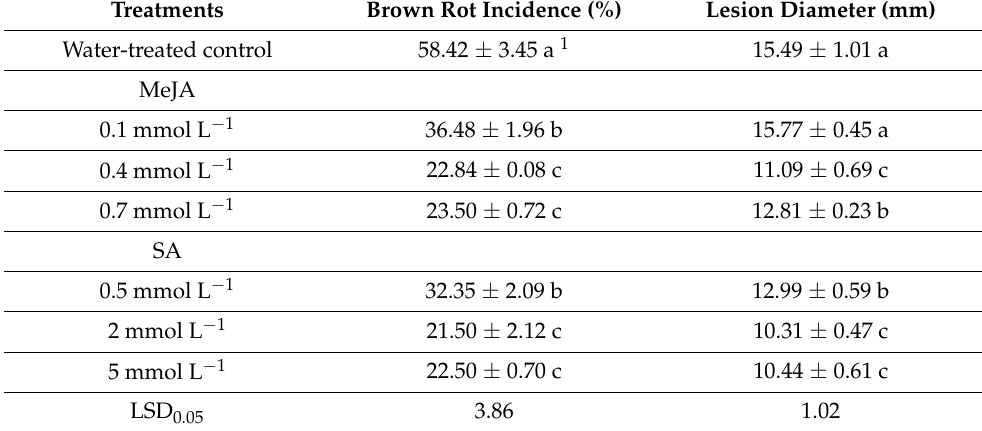
1 Different letters within the columns coupled with the BRI or LD values are significantly different at p = 0.05 according to LSD t -tests. Data are means ± SD from a triplicate